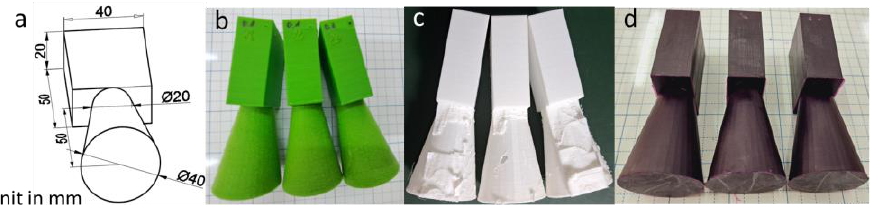
Figure 2. ( a ) Design of the model for the surface roughness test and IC casting. ( b – d ) PLA – , PVB – , and CW – printed parts, respectively.